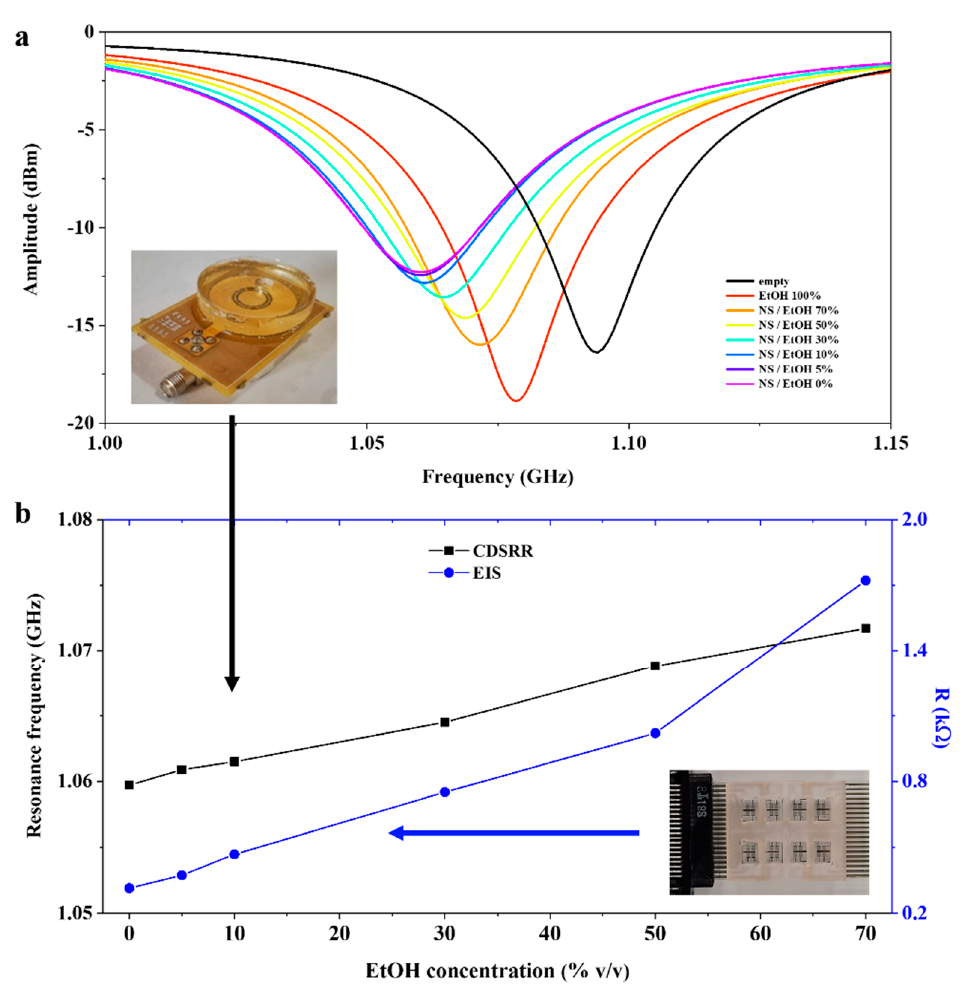
Figure 5. ( a ) Measured S 11 of CDSRR curves for various NS-ethanol mixtures at different volume fractions. ( b ) Resistance (R) and resonant frequency for different NS-ethanol volume fractions extracted with EIS and CDSRR sensors, respectively.